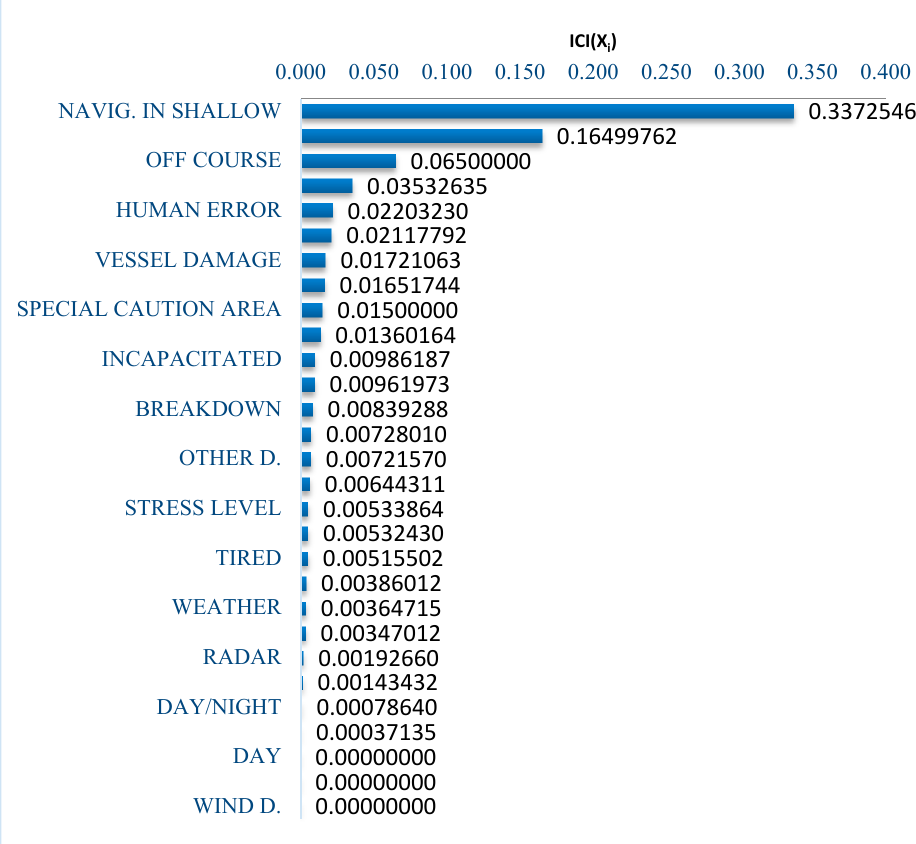
Figure 14. Ranking of risk factors for grounding.